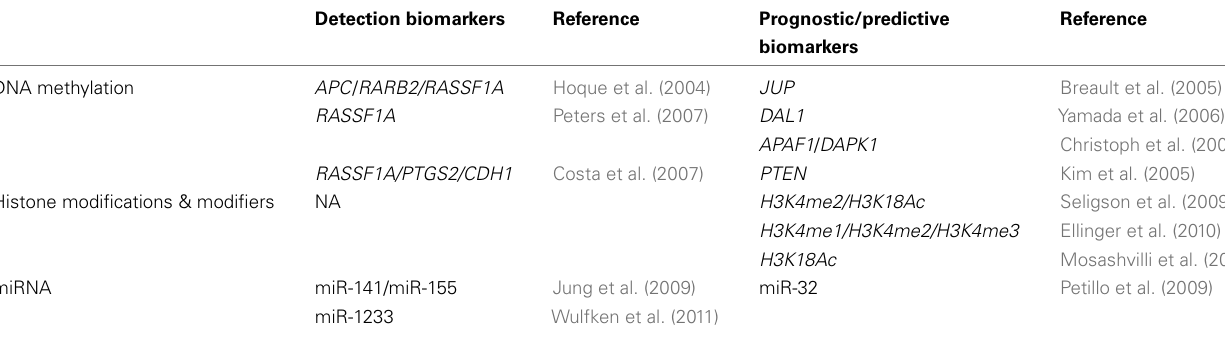
Table 4 | Diagnostic and prognostic information in renal cell tumors provided by epigenetic